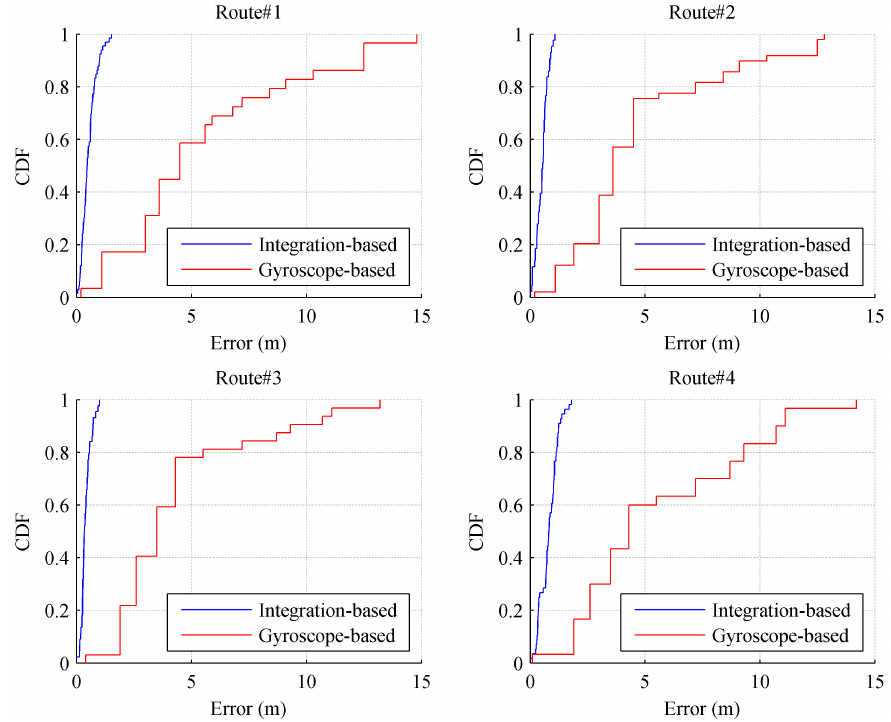
Figure 8. The quantitative results of annotation